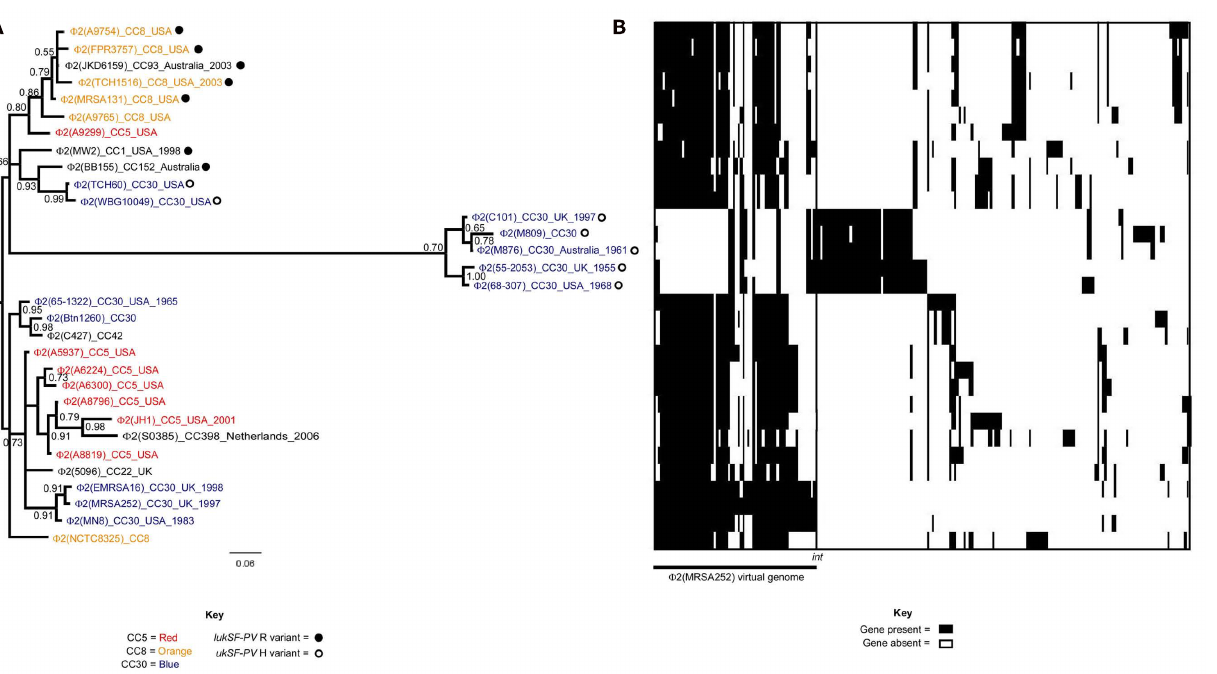
FIGURE 1 | Evolutionary relationships of ϕ 2 S. aureus prophage. (A) Phylogenetic analysis of 31 ϕ 2 prophage is shown. Each prophage is named by the family it belongs to ϕ 2, and then the name of the sequenced S. aureus genome it originates from (in parentheses). Additional information is giving on the clonal complex (CC) of the S. aureus isolate, as well as the country of origin and year of isolation if data was available. Branches are colored by CC lineage if more than one prophage originates from the same CC.The